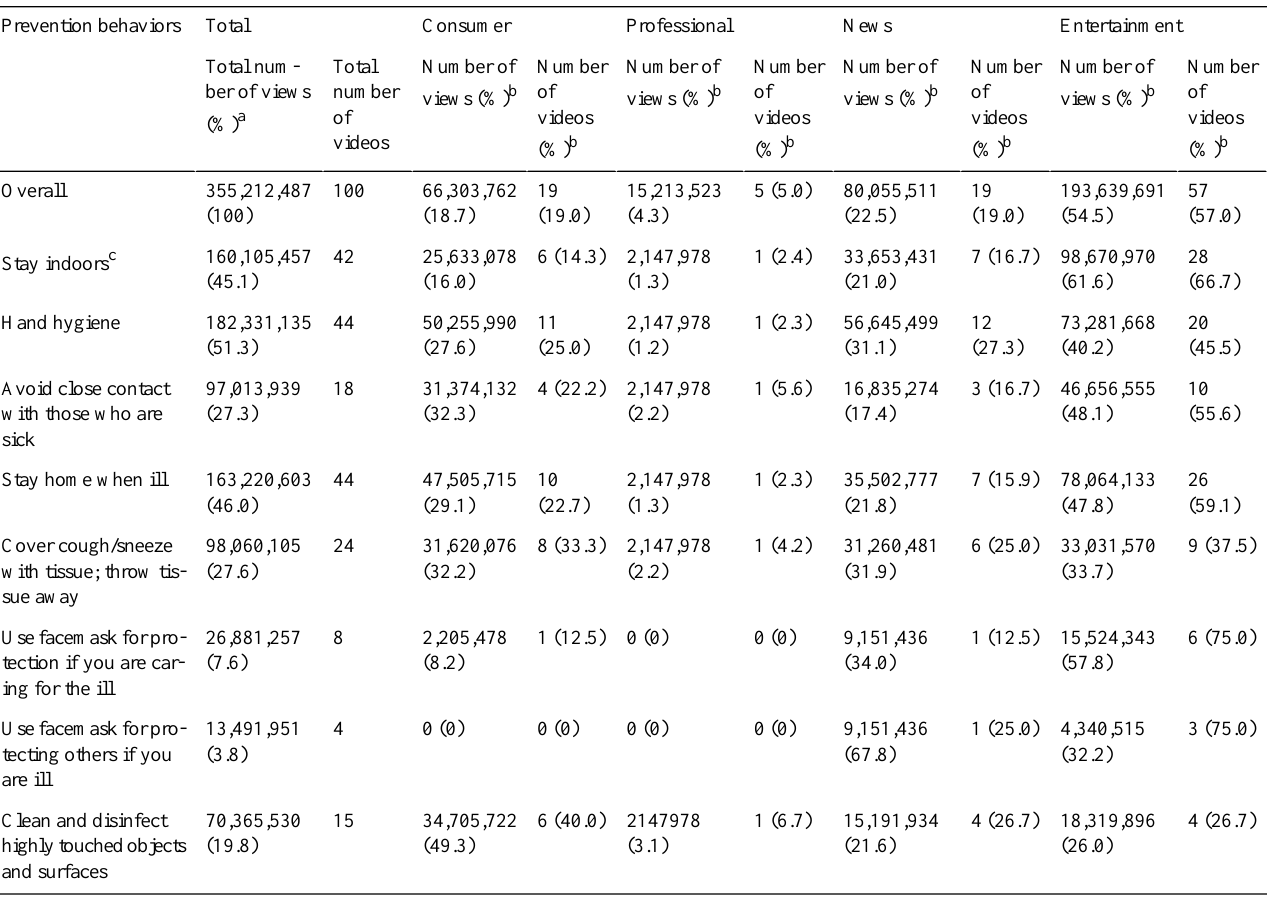
Table 2. Behaviors to mitigate transmission of COVID-19 covered in widely viewed YouTube videos by source in March 2020. EntertainmentNewsProfessionalConsumerTotalPrevention